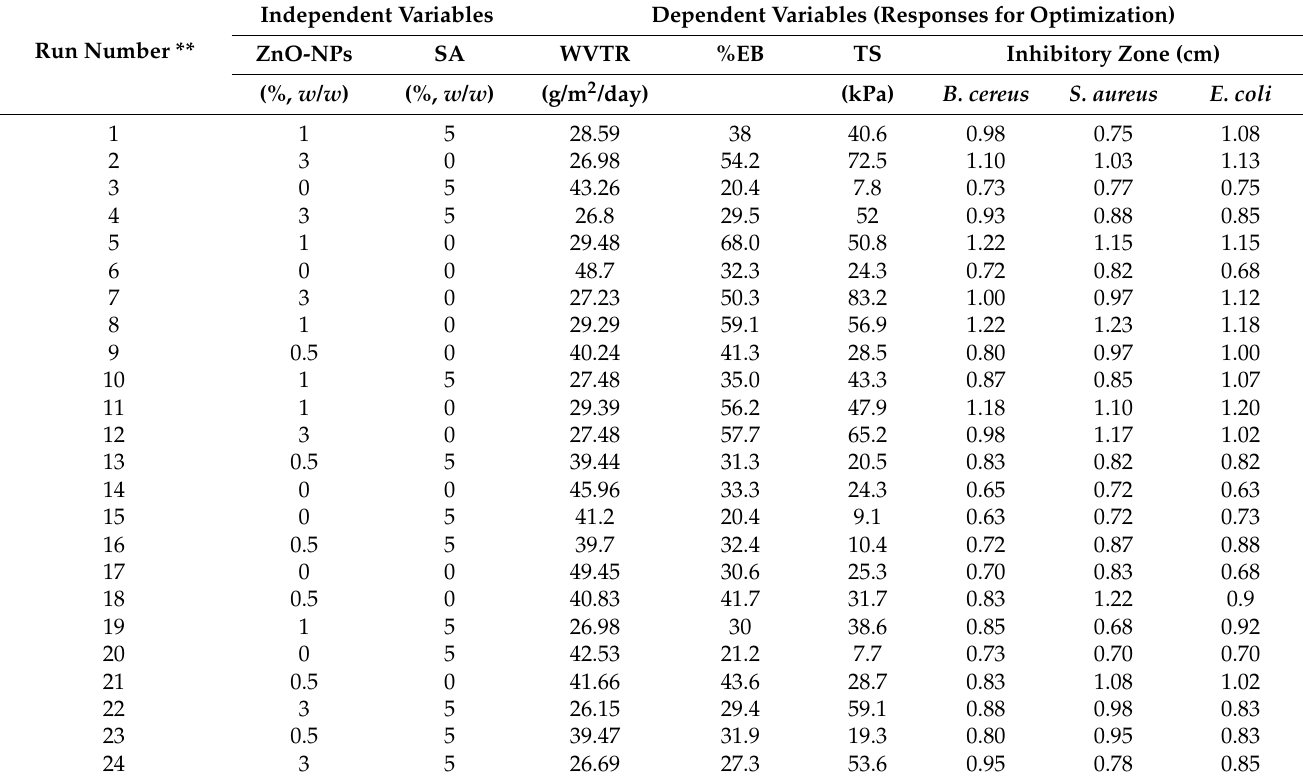
Table 1. Full factorial design run matrix and the obtained multiple